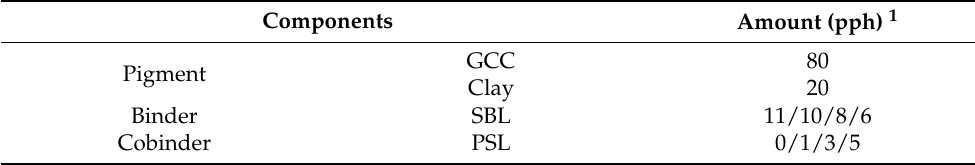
Table 1. Formulation of coating